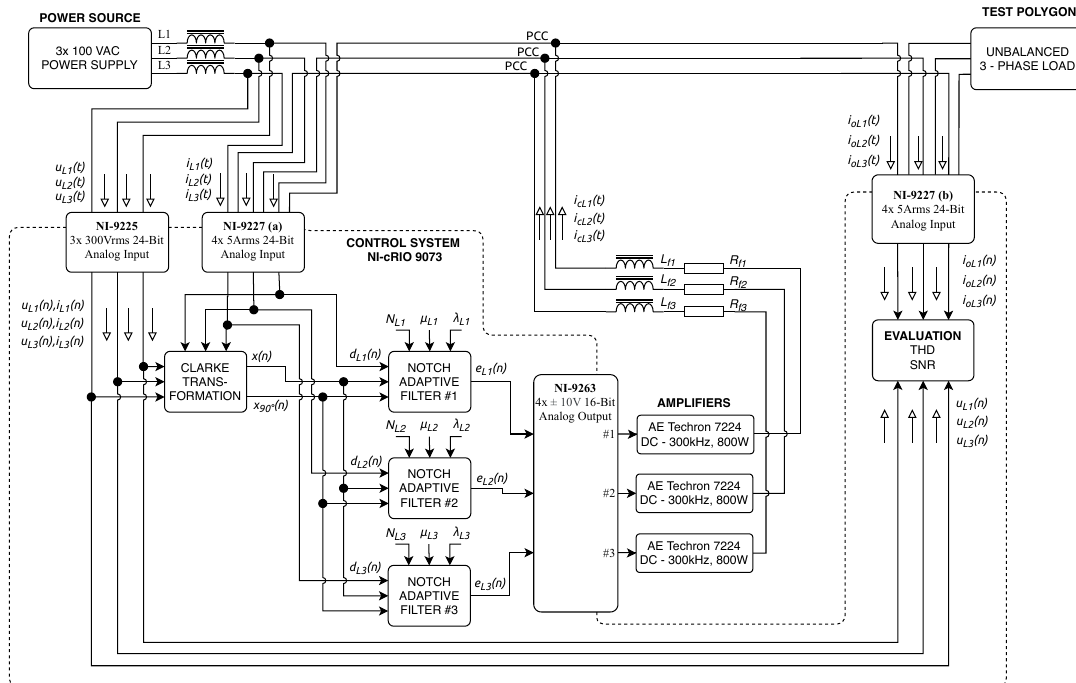
Figure 20. Schematic diagram of realized laboratory experiment with AE-Techron 7224 amplifiers used as